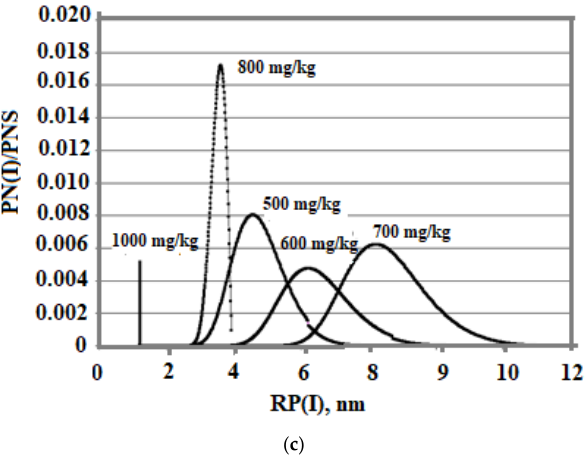
Figure 10. Dependence of C s on T p ( a ), S N on T p ( b ), and particle size distribution ( c ). The temperature decreases from 100 to 20 °C and taun0 = 360 min.